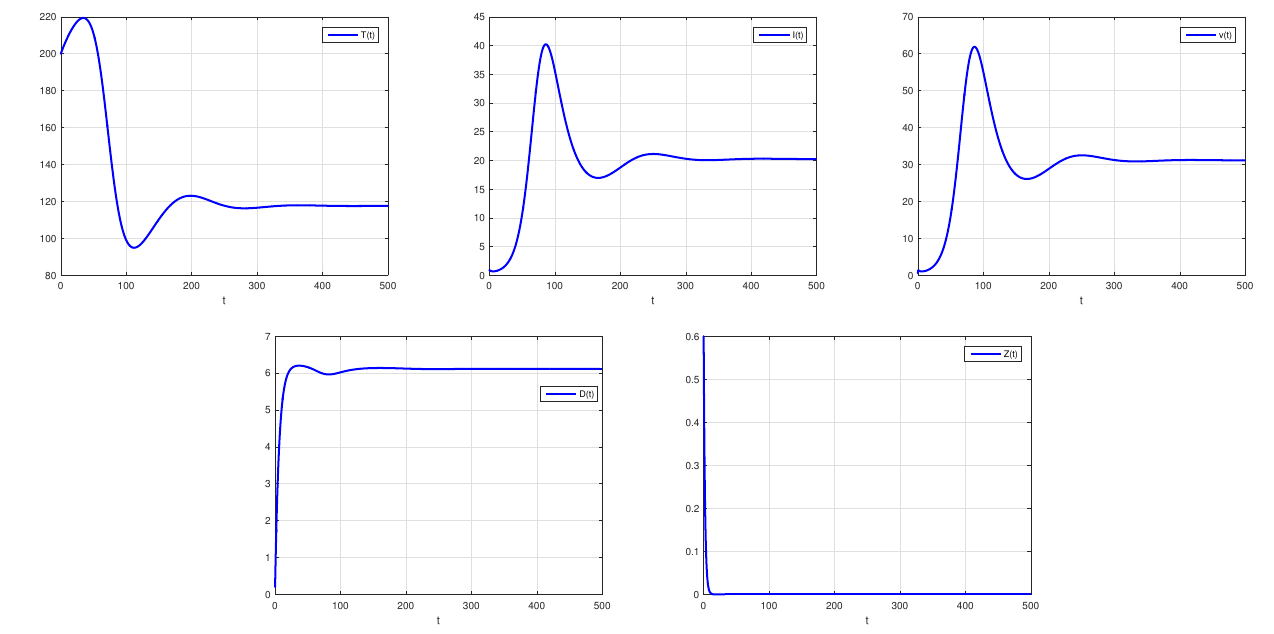
Figure 3. The solution curves of the model (2). Here, the immunity-inactivated equilibrium E 1 ≈ ( 117.5671563,20.2366224,31.13326522,6.110219209,0 ) is globally asymptotically stable.